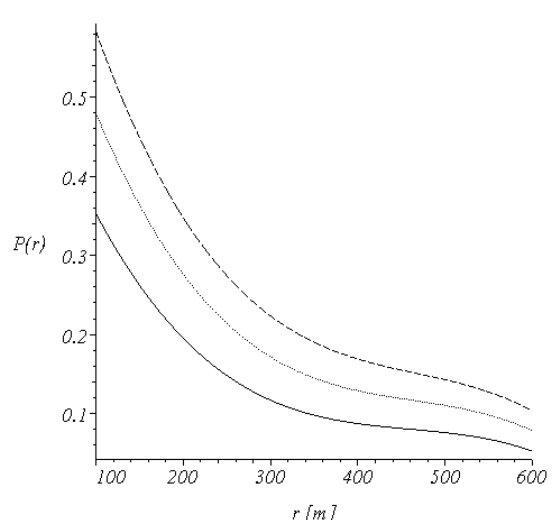
Fig 4. Dependence of hit probabilities on distance in offence if the bound time is: line – 2 sec., dots – 3 sec., strokes – 4 sec. Soldiers bearing automatic rifles choose enemy soldiers firing at them or those that are nearest to them and shoot after taking aim. Machine gunners fire partially taking aim or conduct area firing; grenade launcher and mortar fire usually destroys group targets or heavy